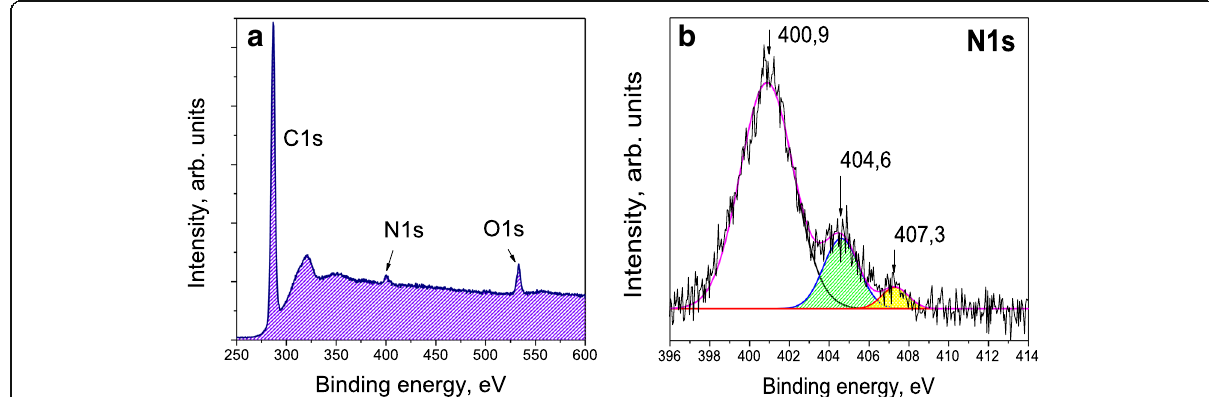
Fig. 5 XPS spectra of acid-purified DNDs after Ar ion etching: a overview of the spectrum in the range 250-600 eV and b N1s photoemission